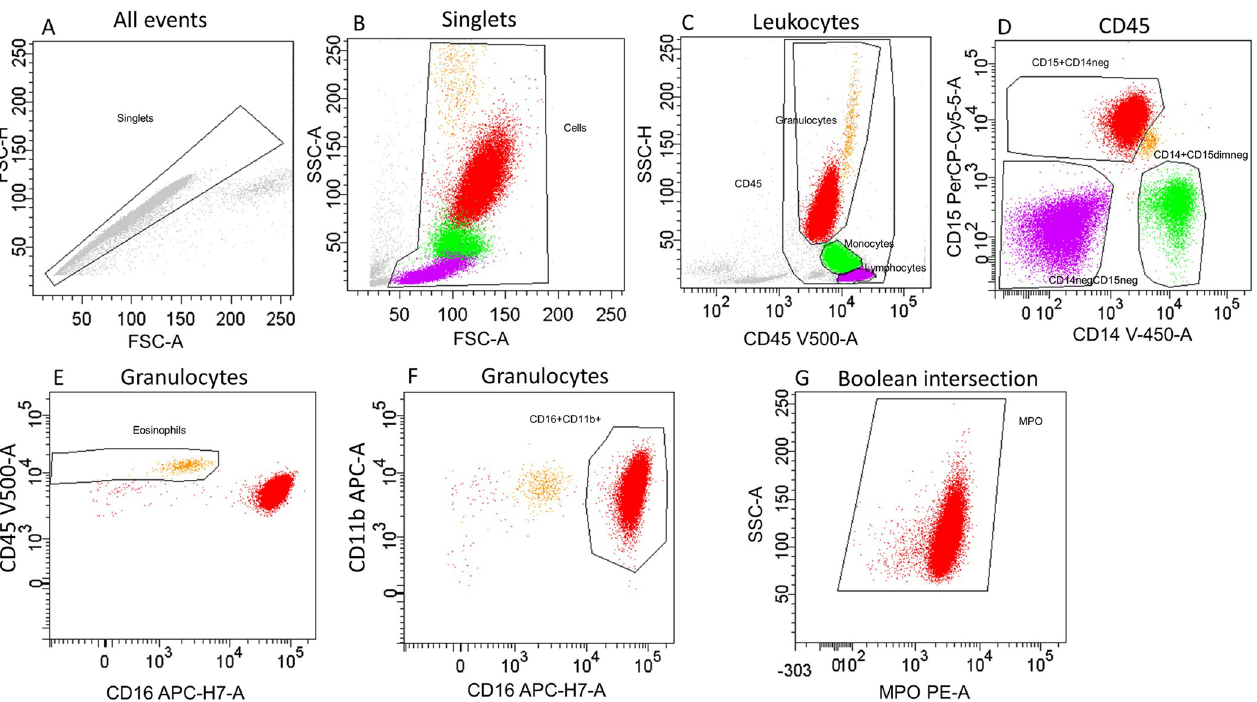
Fig 1. Original flow cytometric gating strategy for quantifying peripheral blood neutrophil myeloperoxidase expression. CD45+ cells were first individualized by crossing the singlet gate (A), FSC-SSC leukocytes (B), and CD45-positive gate (C). Three populations including granulocytes (CD15+ CD14- ), monocytes (CD14+ CD15dim/-), and lymphocytes (CD15- CD14-) were identified (D). Eosinophils were individualized by CD45high CD16 low (E). Mature neutrophils were visualized by [CD15+ CD14-] [CD45low CD16 high] [CD16+ CD11b+] and selected by Boolean intersection: [CD15+ CD14-] [CD16 + CD11b+] with exclusion of [CD45high CD16 low] [CD14+ CD15dim/-] [CD15- CD14-] (F). RCV for MPO was estimated on the MPO gate conditioned on all visualized granulocytes (red dots) without threshold (G). The populations identified were lymphocytes (purple), monocytes (green), eosinophils (orange), MPO mature neutrophils (red). Abbreviations: CD = cluster of differentiation; FSC-A = forward scatter area; FSC-H = forward scatter height; MPO = myeloperoxidase; RCV = robust coefficient of variation; SSC-A = side scatter area; SSC-H = side scatter height.